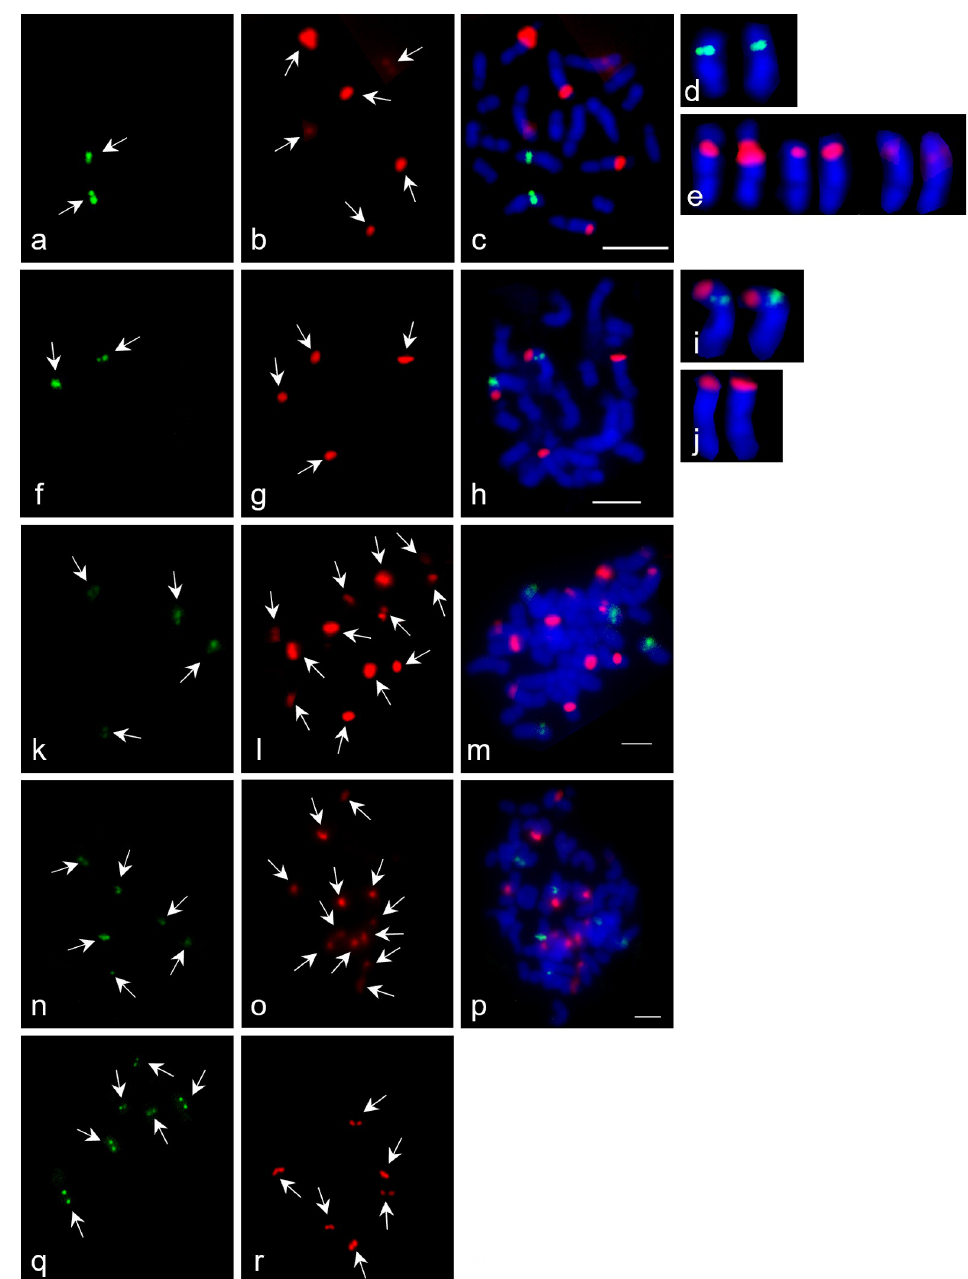
Fig 2. FISH on mitotic metaphase spreads of Asparagus species using 5S rDNA (green) and 45S rDNA (red) as probes. The chromosomes were counterstained with DAPI (blue). (a-e) Diploid A . officinalis ‘Ravel’ showing two signals with 5S rDNA (a, d) and six signals with 45S rDNA (b, e); (c) double FISH with both 5S and 45S rDNA. (f-j) Diploid A . verticillatus 2 (f) with two 5S rDNA signals (g) and four 45S rDNA signals (h); double FISH with both 5S and 45S rDNA signals, i) one chromosome pair with 5S and 45S rDNA signals, j) one chromosome pair with 45S rDNA. (k-m) Tetraploid A . prostratus 2 showing k) four 5S rDNA signals, l) twelve 45S rDNA signals and m) double FISH with both 5S and 45S rDNA signals. (n-p) Hexaploid A . maritimus 4 with n) six 5S rDNA signals, o) twelve 45S rDNA signals and p) double FISH with both 5S and 45S rDNA signals. (q-s) Hexaploid A . aethiopicus showing six 5S rDNA signals (q), six 45S rDNA signals (r) and double FISH with both 5S and 45S rDNA signals (s). Scale bar = 10 μ m.